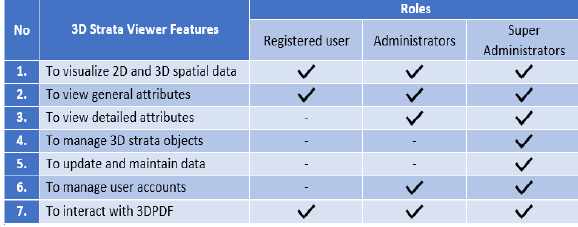
Table 2. User interactions with 3D Strata